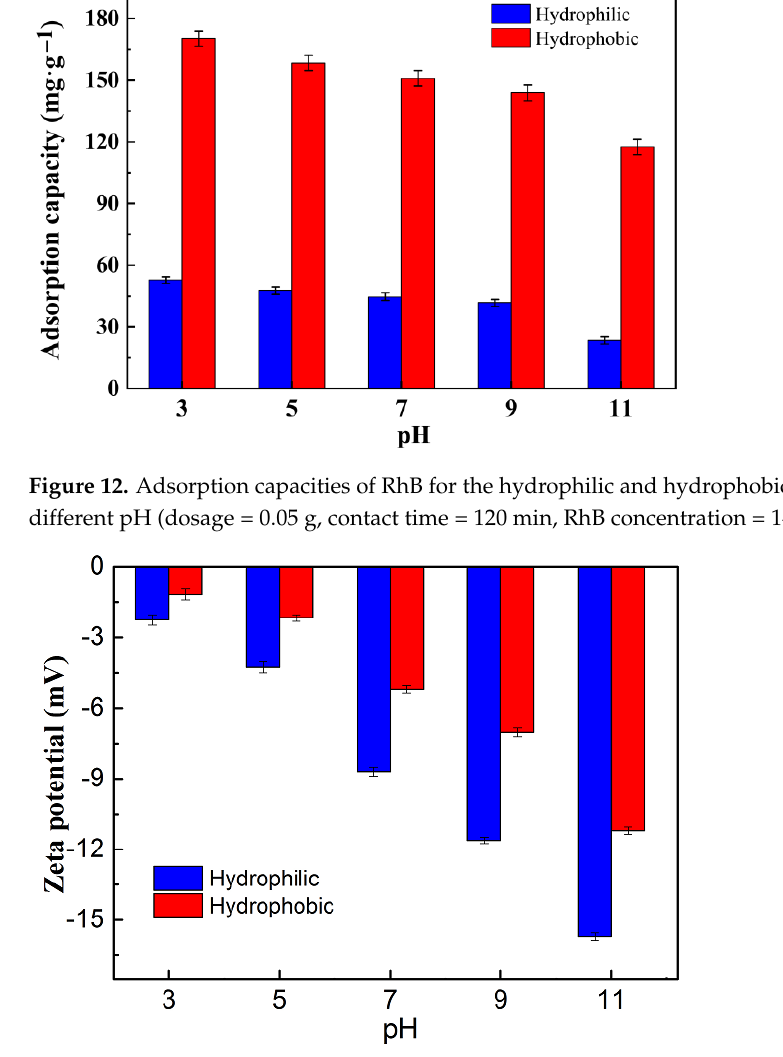
Figure 13. Effect of solution pH on the zeta potentials of hydrophilic and hydrophobic ZrO 2 -SiO 2 xerogels.